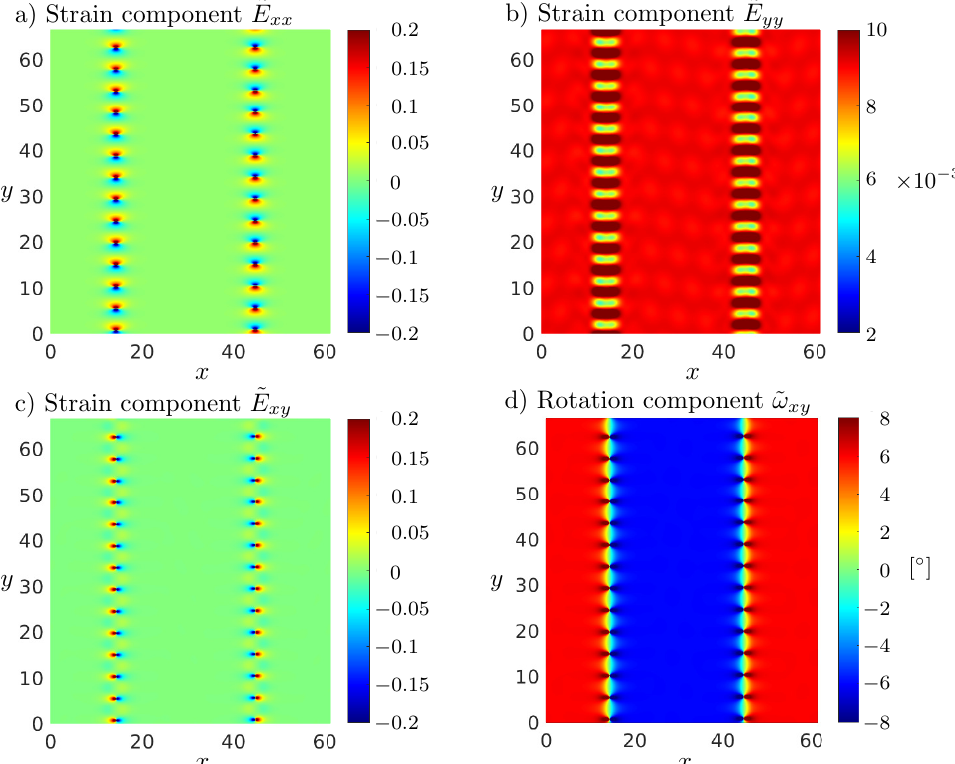
Figure 9. Examples of strain and rotation components based on the discrete deformation gradient ˜ F in Equation (32), evaluated by GPA. Strains and rotations are found by Equations (13) and (17), respectively. ( a ) Strain component ˜ E xx ; ( b ) Strain component ˜ E yy ; ( c ) Strain component ˜ E xy ; ( d ) Rota- tion component ˜ ω xy (rotation around the z-axis, measured in degrees [ ◦ ] ). Note the different scale of the color legend in figure ( b ), compared to those in figures ( a , c